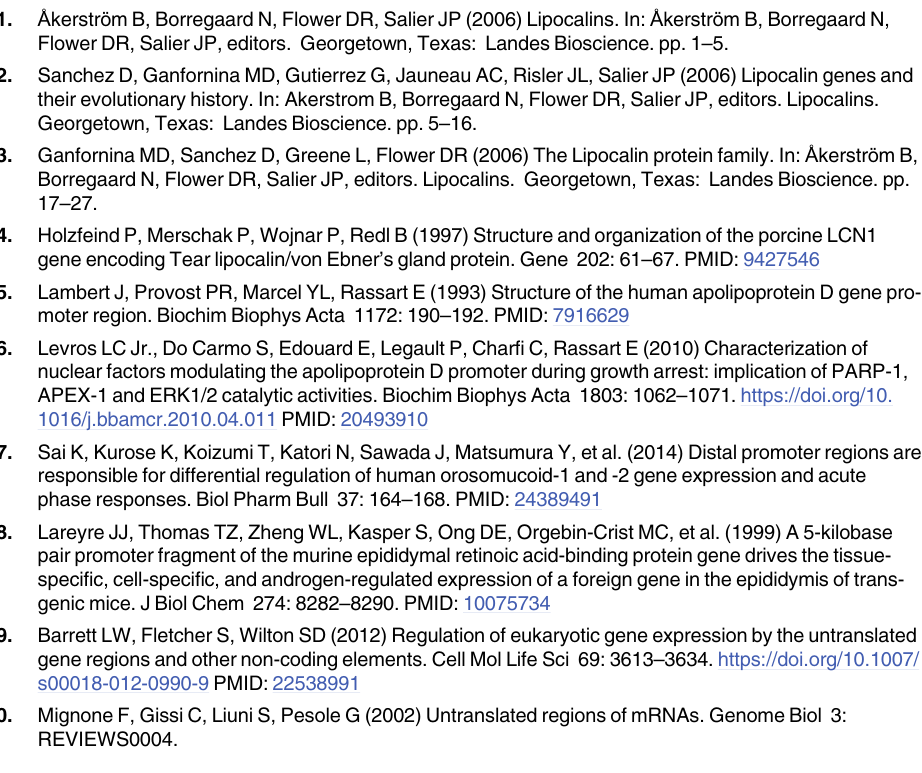
S5 File. Sequences used in Fig 4. S1 Table. Promoter prediction